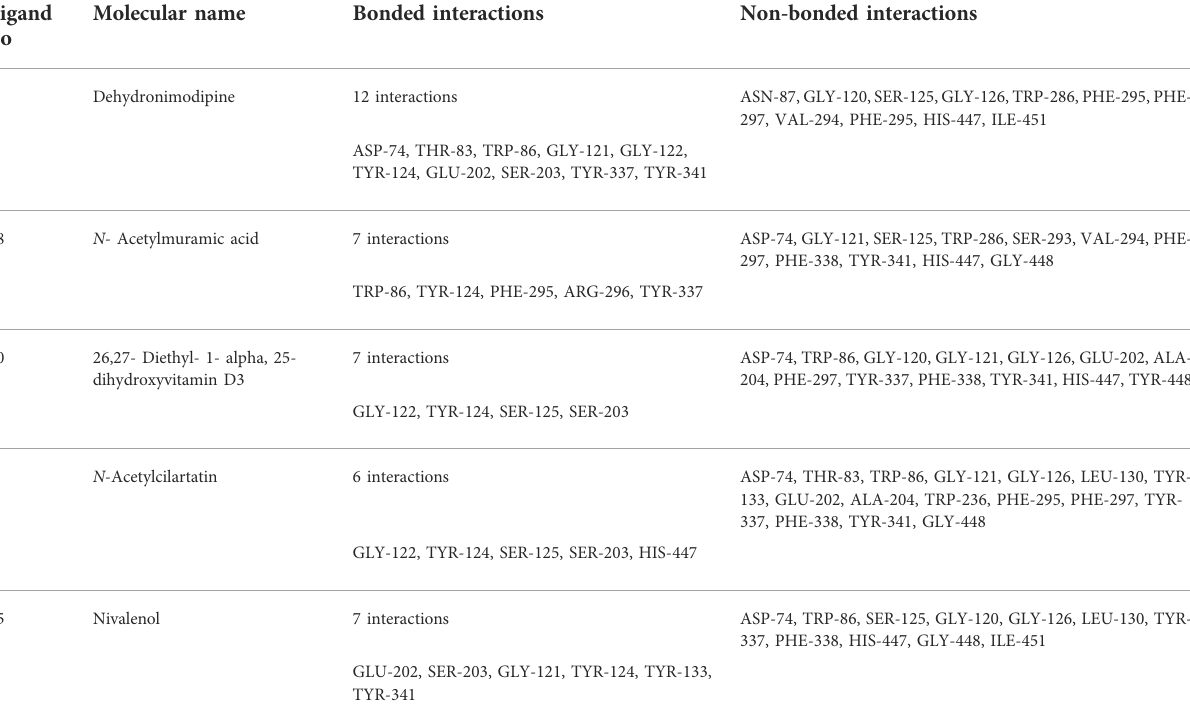
TABLE 3 Molecular docking binding energy and interactions of fi ve ligands against